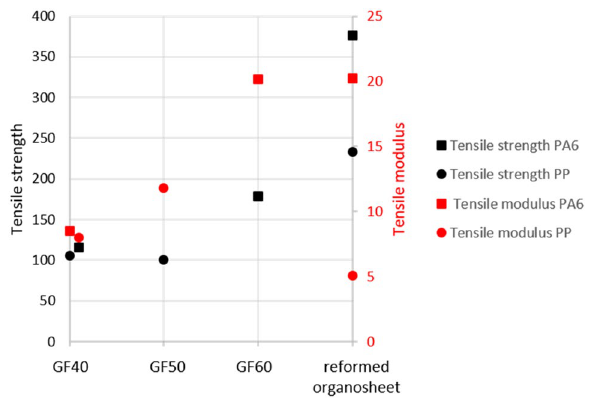
Fig. 12 Comparison of tensile properties of recovered orga- nosheets (5 cycles) and mechanically recycled and compounded materials [23,